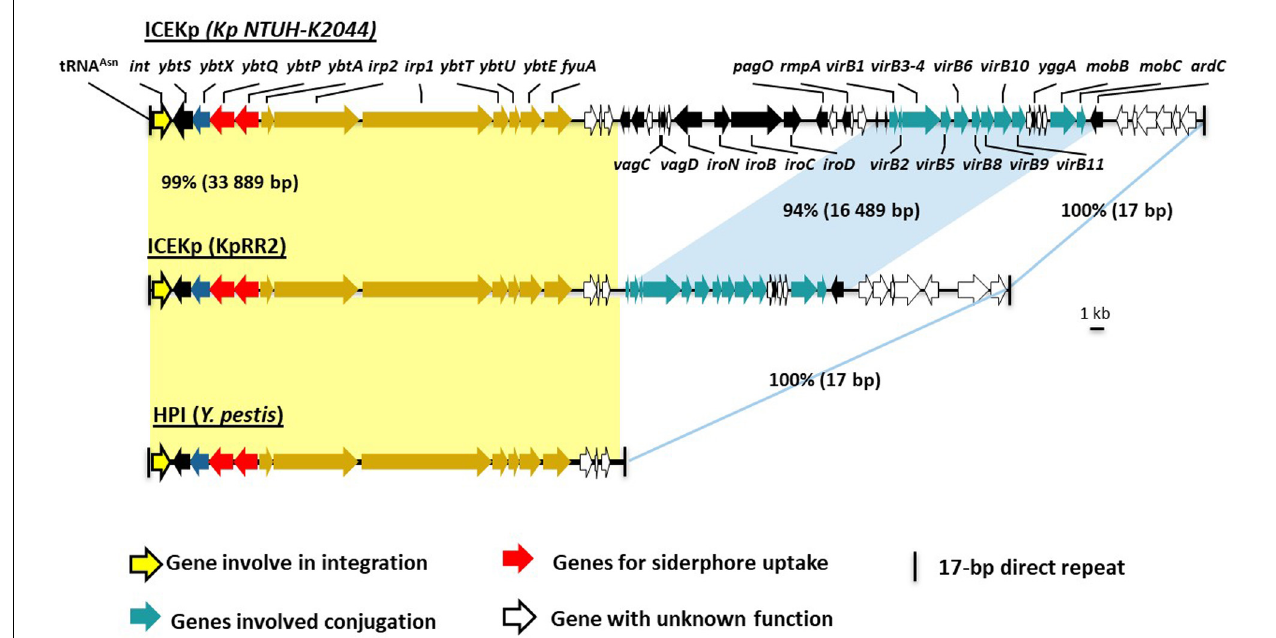
FIGURE 1 | Comparison of ICEKp in the study strain KpRR2 with the first characterized ICEKp in strain NTUH-K2044, and with the yersiniabactin gene cluster in Yersinia pestis . The first characterization of ICEKp in K. pneumoniae was in strain Kp NTUH-K2044 (Lin et al., 2008). Yellow shading indicates the synteny and 99% DNA identity between the yersiniabactin gene cluster in the study strain KpRR2 and that in Yersinia pestis (AF091251) High Pathogenicity Island (HPI). The genes cluster responsible for conjugation are indicated by blue shading region, these share 94% identity.